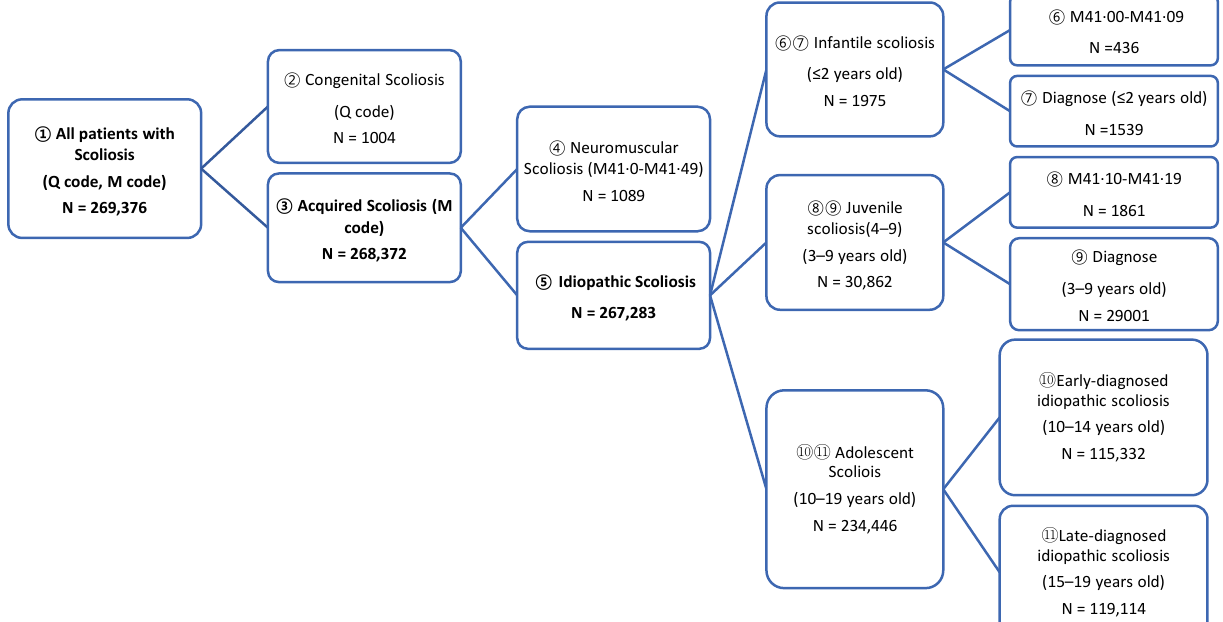
Figure 1. The diagram shows the nationwide scoliosis investigation from The Health Insurance Review and Assessment Service data analysis.